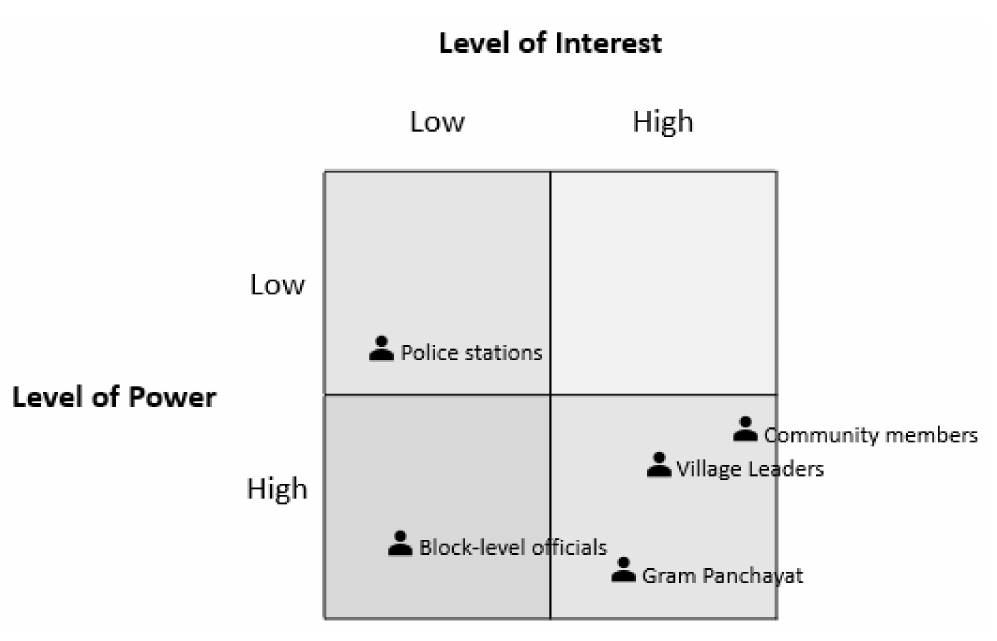
Figure 2. Stakeholder placement in Mendelow’s